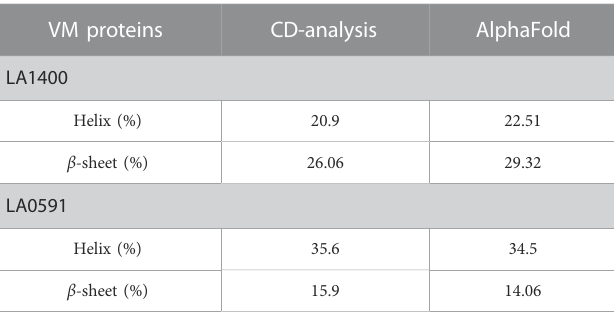
TABLE 1 Comparative validation of secondary structure content by CD- spectroscopy and AlphaFold derived structure.